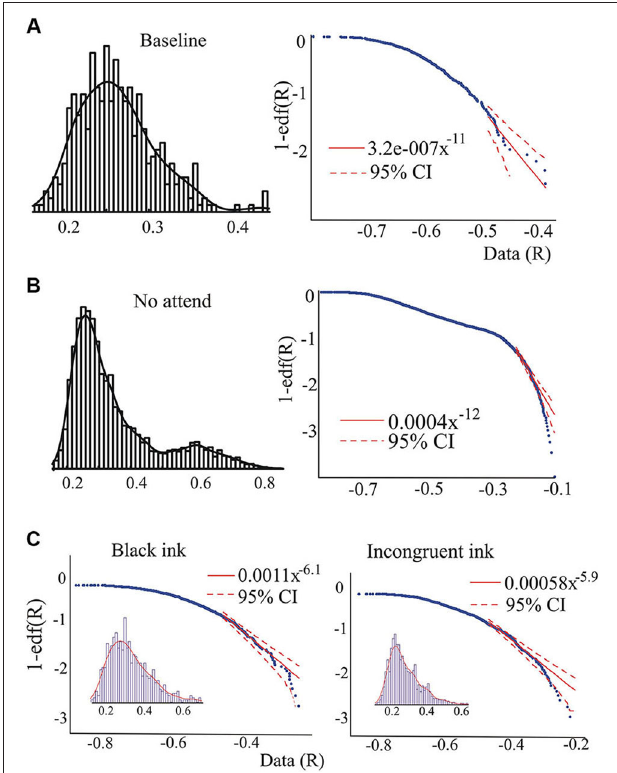
FIGURE 2 | Examples of the pdf and its characteristics . (A) and (B) , pdf of the synchrony index and the edf corresponding to the baseline and the “not attend” conditions of one individual (non-ASD) performing the auditory attention task. In the right-hand side graphs, the logarithmic plots of the edf versus the data ( R -values) are presented. Dashed red lines indicate 95% confidence for a power law, showing the presence of outliers in B . Note as well the change in the pdf, becoming almost bimodal in B , and as well the possible presence of a power law regime in the middle of the edf. Fitting the power law in this middle range (70–30% of the values, see Section Materials and Methods for ranges used), the exponent found was 2.4. (C) Data collected from another individual (non-ASD) during performance of the Stroop task, showing the presence of outliers in the tail during the incongruent color condition.